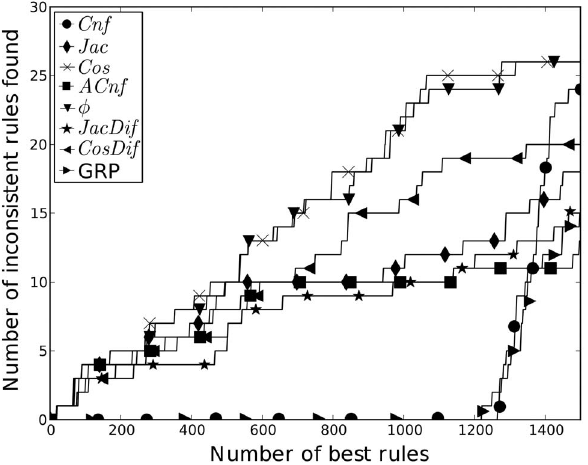
Figure 3. Number of inconsistent rules. The number of inconsis- tent rules found in the best x rules extracted by the given metric. The best x rules were gathered from 20,000 and then ancestors rules were